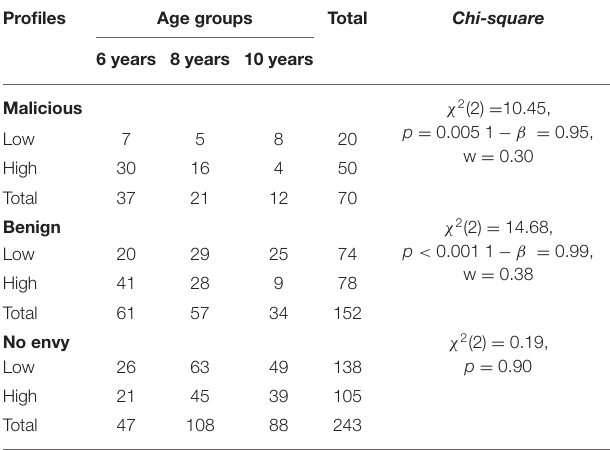
TABLE 6 | High and low allocation profiles by age groups and results of Chi-square